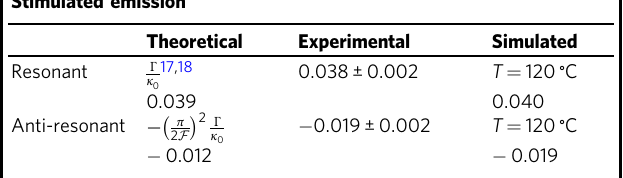
Table 1 Cavity-pulling coef fi cient in optical